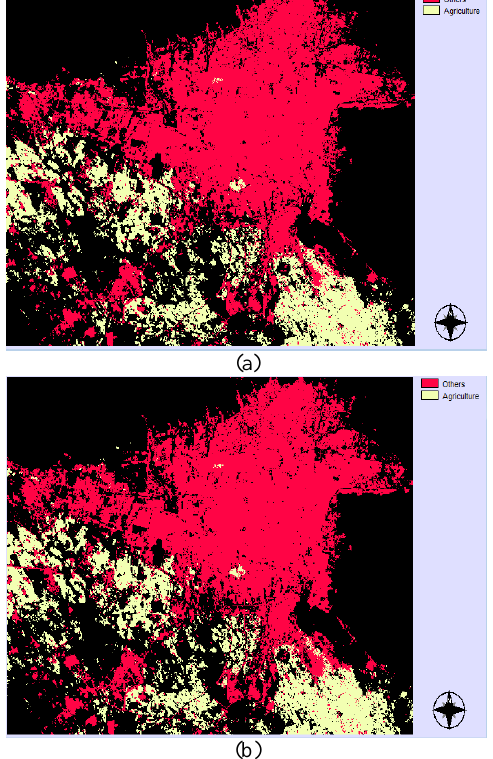
Figure 10. The predicted land use map of (a) 2020, and (b) 2025